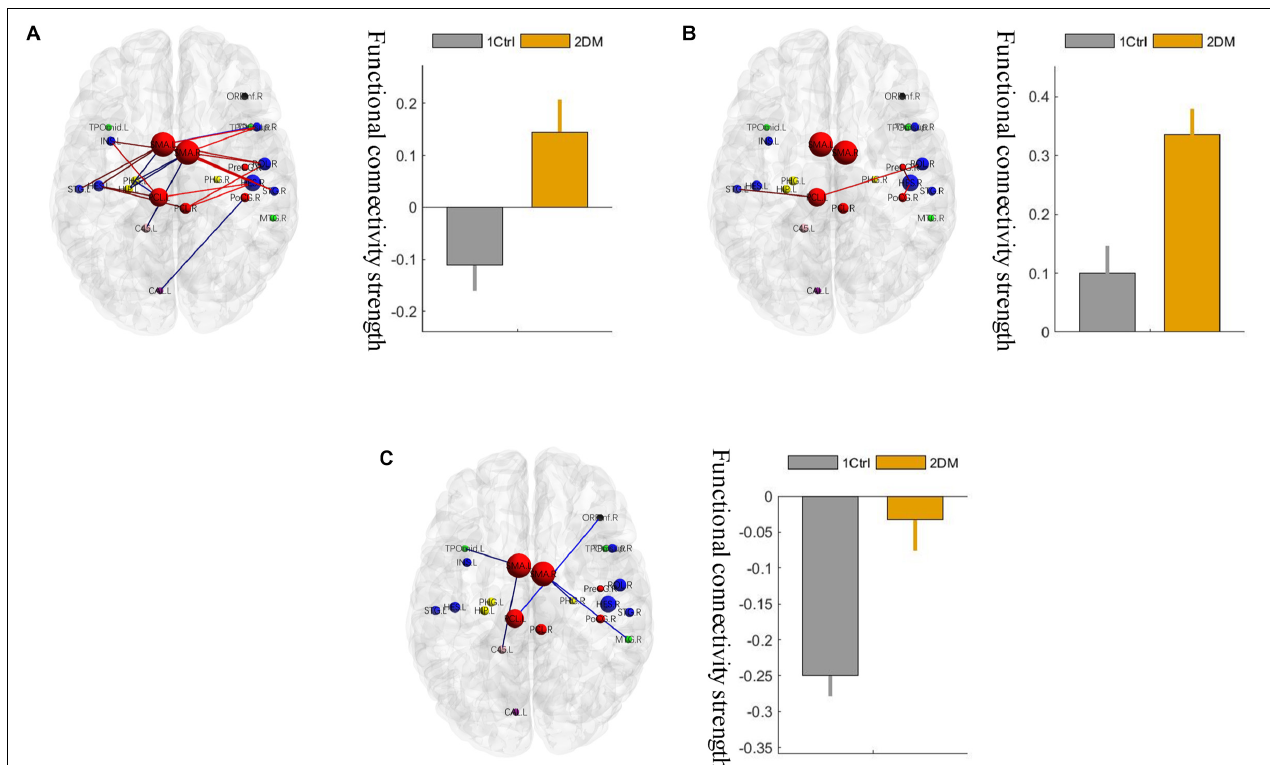
FIGURE 2 | Three different changed patterns of the 33 functional connectivities. (A) Pathological between-network positive connectivities. Different colors represent connectivities between different networks; the red links represent the connections between the sensorimotor network and the auditory network; the blue links represent the connections that are not between the sensorimotor network and the auditory network. (B) Hyperconnectivity: the red links represent enhancement of positive connectivity. (C) Hypoconnectivity: the red links represent reduction of negative connectivity. The error bars in the figures represent the variance. 1 ctrl: the first group is the control group; 2 T2D: the second group is the type 2 diabetes